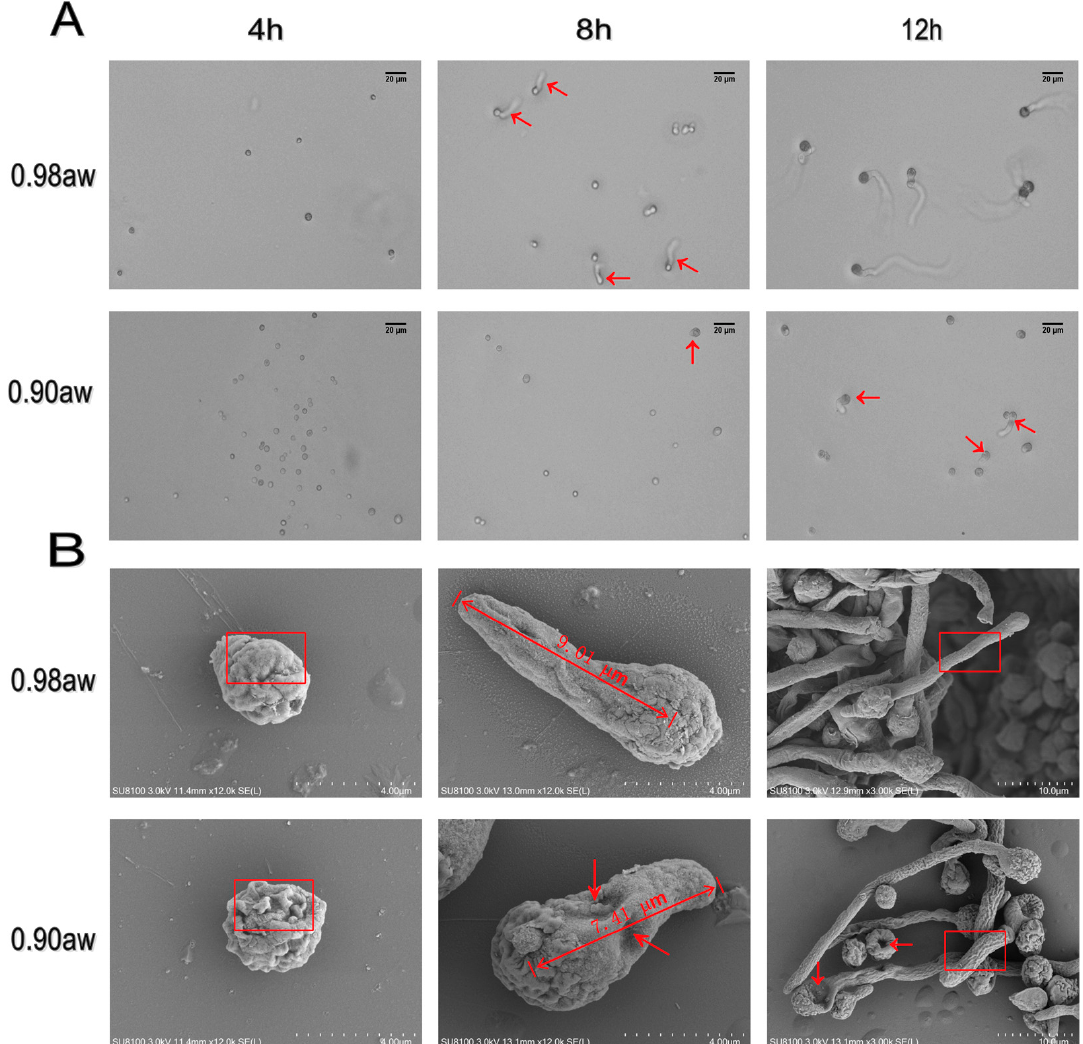
Figure 1. Germination of A. flavus conidia as observed by microscopy. The states of 4 h, 8 h and 12 h were observed by different kinds of microscopy. All conidia were observed under two different a w , 0.98 and 0.90. Germination of A. flavus conidia under two different a w in optical microscope ( A ), bar represents 20 µm; in SEM (scanning electron microscope) ( B ), bar represents 4 µm in 4 h and 8 h, 10 µm in 12 h.